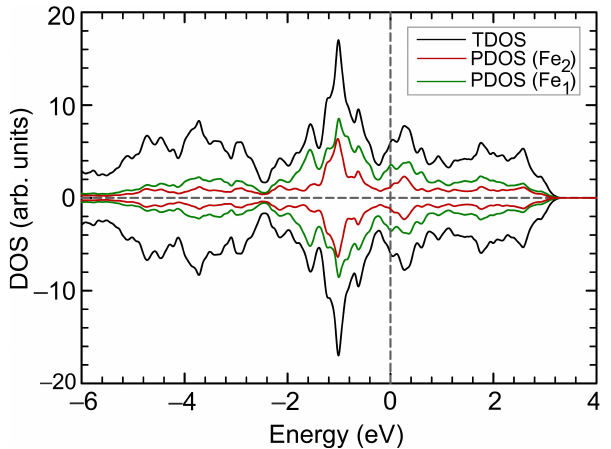
Figure 8. Total and partial DOS for Fe 3 Se 4 under isotropic external pressure of 8.0 GPa. Positive and negative values correspond to spin-up and spin-down channels, respectively. The Fermi level corresponds to zero.